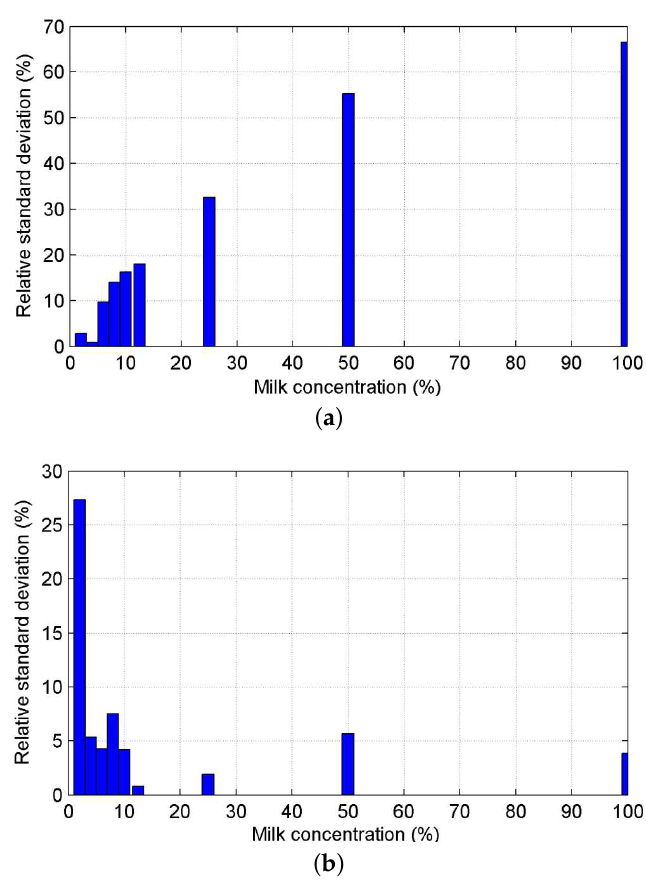
Figure 10. Relative standard deviation of the measured average fluid velocity profile for the circular channel (320-µm diameter) with a 50-µL/min flow rate with various dilution ratios of milk (from 2% to 100% of full milk in water) ( a ) with the cutoff frequency method and ( b ) with the weighted moment